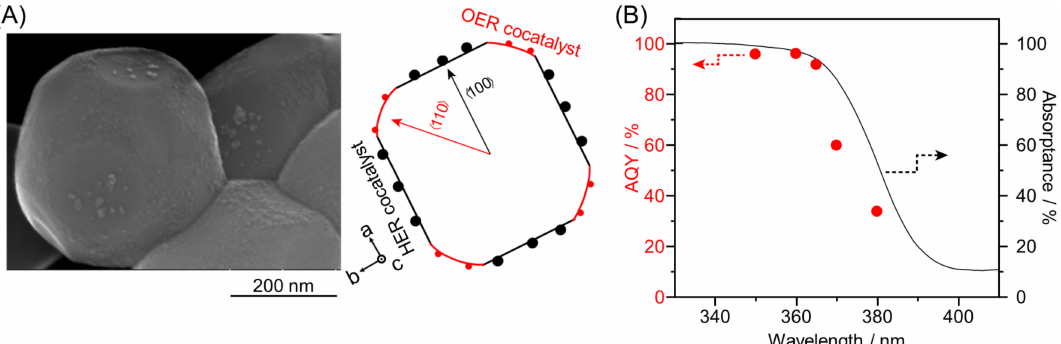
Figure 35. ( A ) SEM and schematic images of SrTiO 3 :Al loaded with various cocatalysts. ( B ) UV–Vis diffuse reflectance spectrum of bare SrTiO 3 :Al (black solid line) and wavelength dependence of AQY during water splitting on Cr 2 O 3 (0.05 wt%)/Rh (0.1 wt%) NPs-CoOOH (0.05 wt%) NPs/SrTiO 3 :Al (red symbols). Reproduced with permission from reference [288]. Copyright 2020 Springer Na- ture Limited.